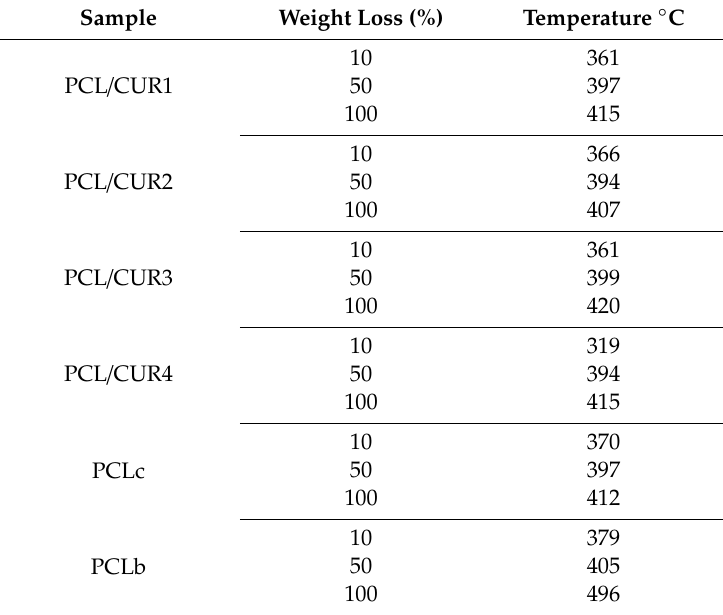
Table 4. % weight loss vs. temperature increment in PCL / CUR sca ff olds.